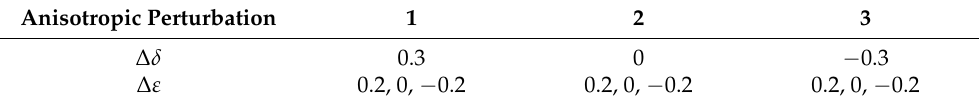
Table 3. The effect of elastic anisotropic perturbation on the reflection coefficient.